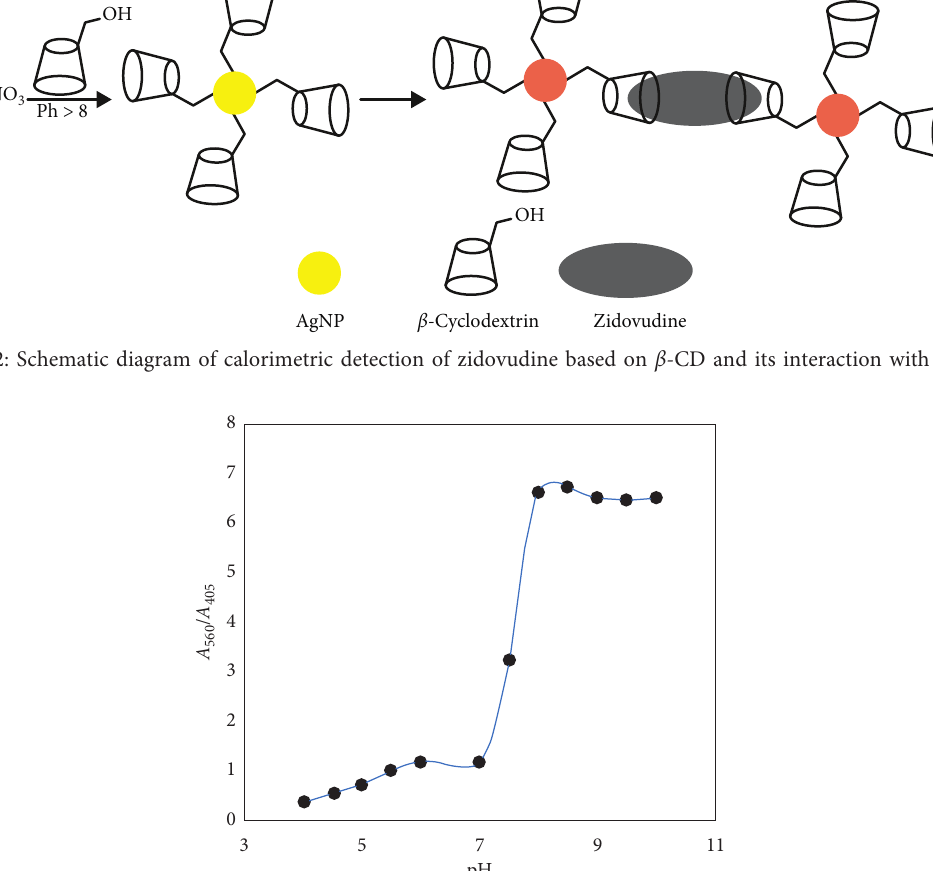
Figure 5: UV-Vis spectra of AgNPs prepared under different pH values. Experimental conditions: 5.0 × 10 − 4 M of zidovudine, pH 4.0–10.0 in HCl/NaOH solution, and response time of 15min.